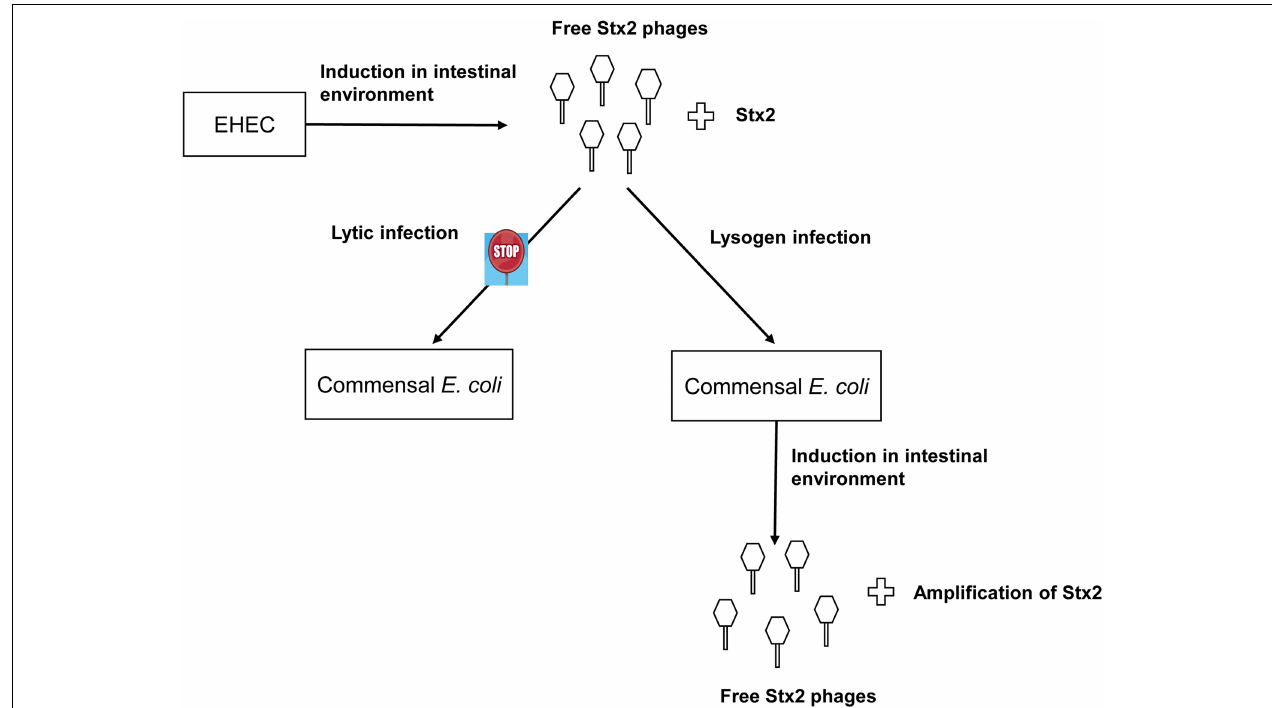
FIGURE 4 | Suggested model of commensal E. coli contribution to Stx2 production in the intestinal tract. The Stx2-phage φ 734 are produced by its EHEC host and infect susceptible commensal E. coli strains lysogenically. The commensal E. coli φ 734 lysogens enter the